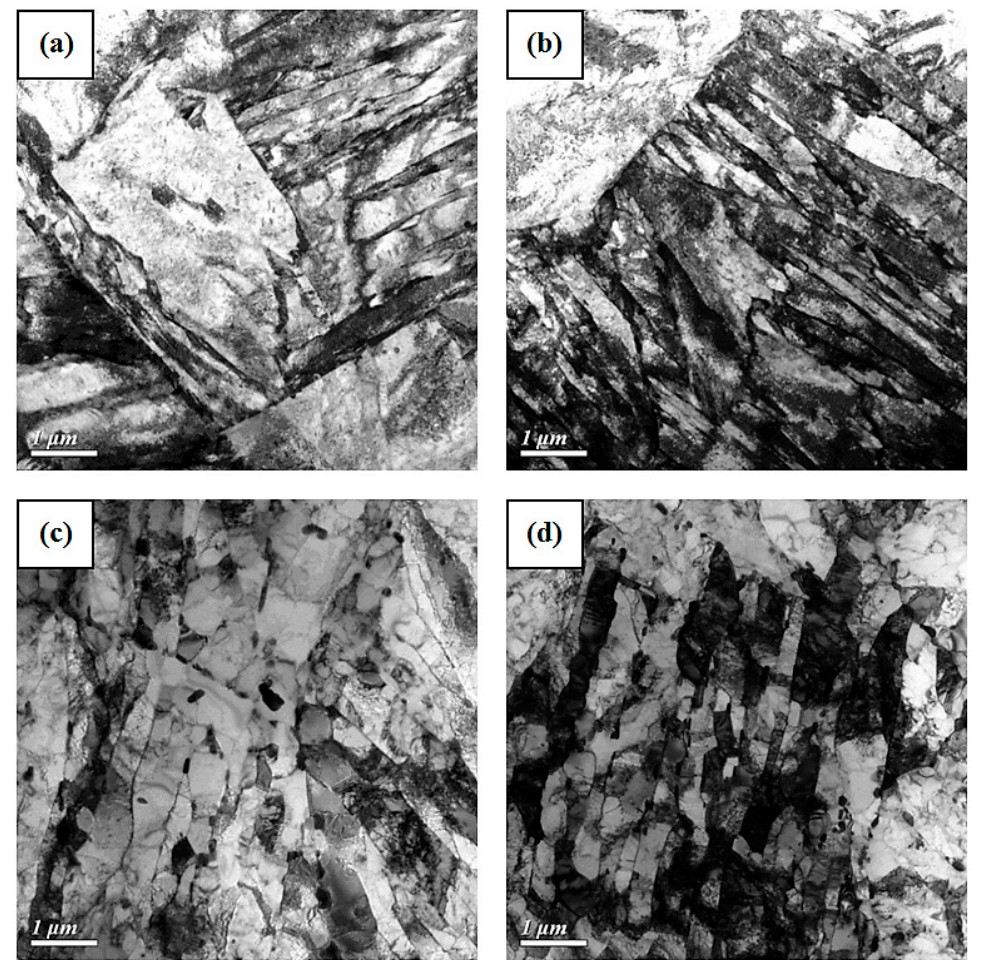
Figure 5. Transmission electron microscope (TEM) micrographs of the ( a ) 1060N, ( b ) 940N, ( c ) 1060NT, and ( d ) 940NT samples.